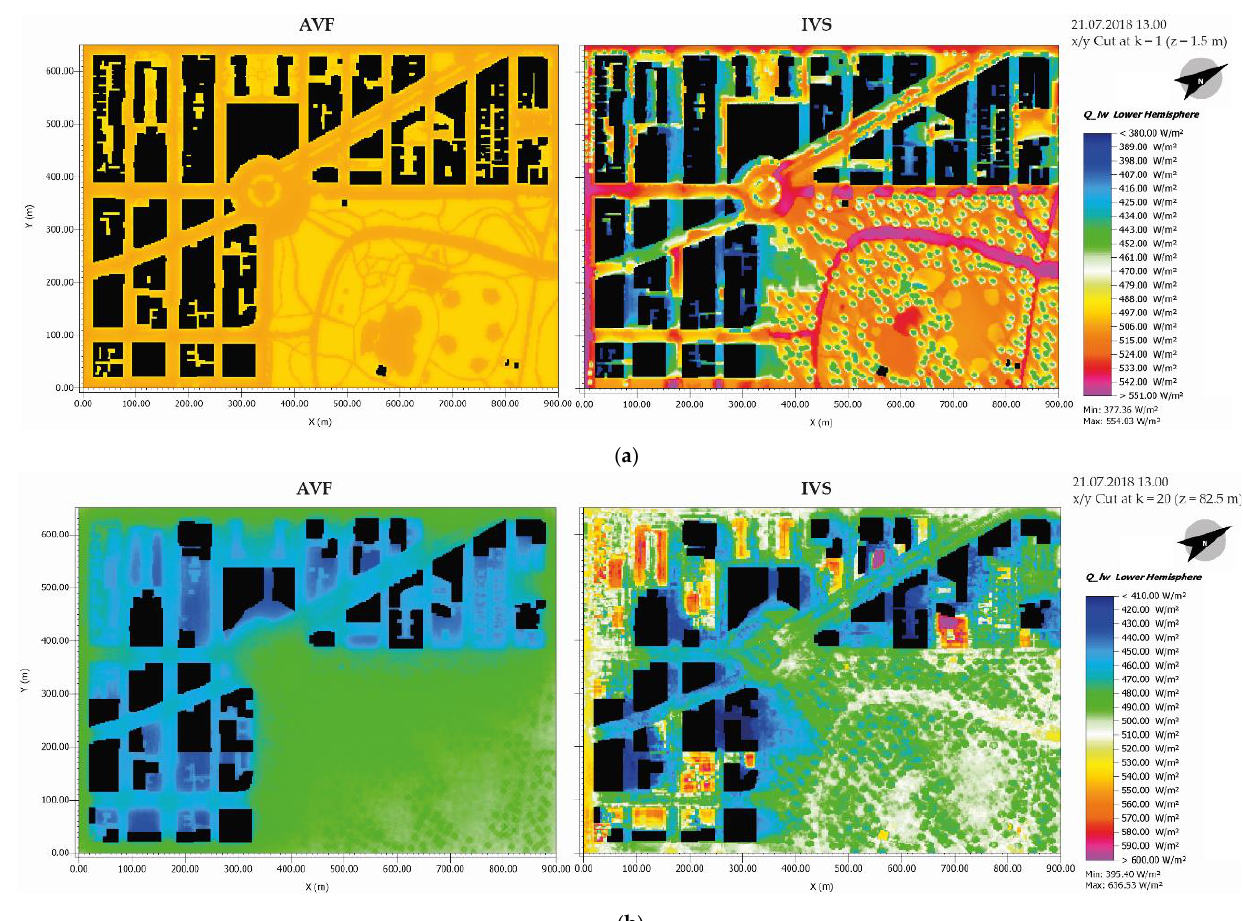
Figure 5. Comparison of proof-of-concept simulation results between AVF and IVS for longwave radiation received from the lower hemisphere at 13.00 in a height of 1.5 m ( a ) and in a height of 82.5 m ( b ), respectively.